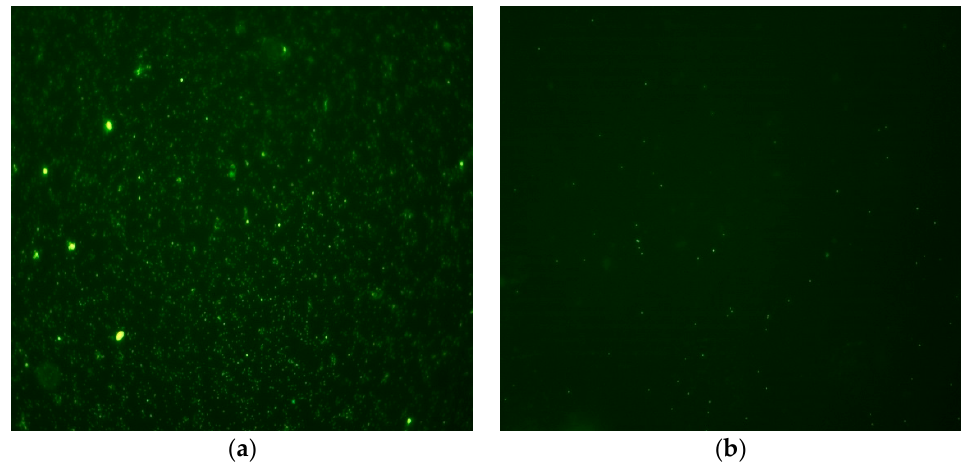
Figure 8. Virus particles (VP) stained with SYBR ® Gold fluorochrome ( a ) in treated wastewater; ( b ) after filtration with a UF 400 kD membrane at the end of filtration (EF). Nikon Eclipse 90i microscope and digital camera Nikon DS-5Mc-U2 were used. Pictures done in Gdansk University of Technology, Faculty of Civil and Environmental Engineering, Department of Water and Wastewater Technology, photo: K. Jankowska.